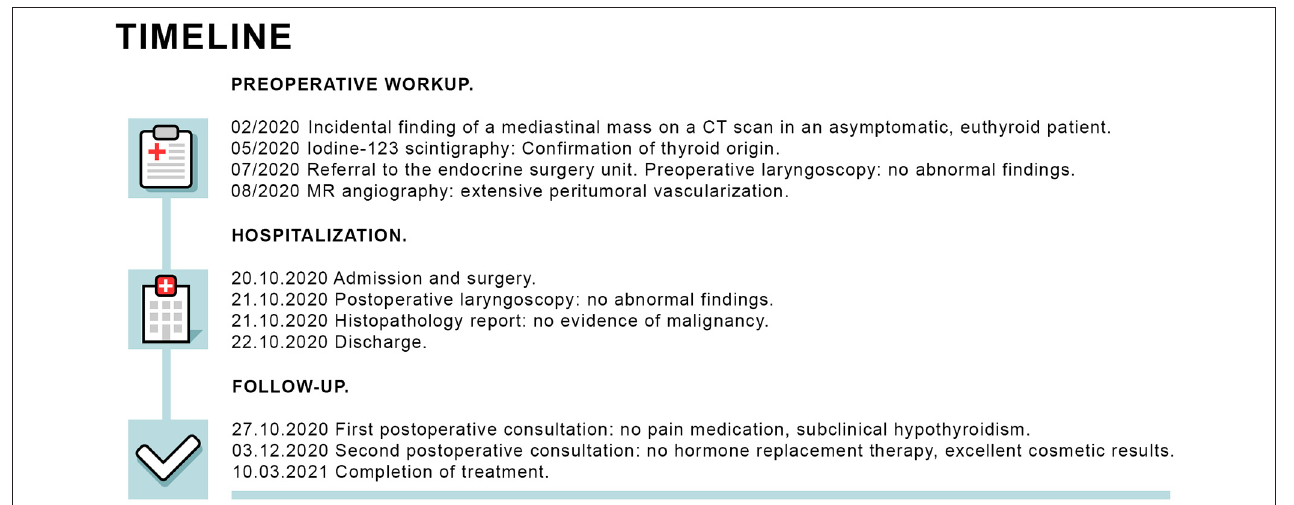
FIGURE 4 | Timeline of preoperative workup, hospitalization and